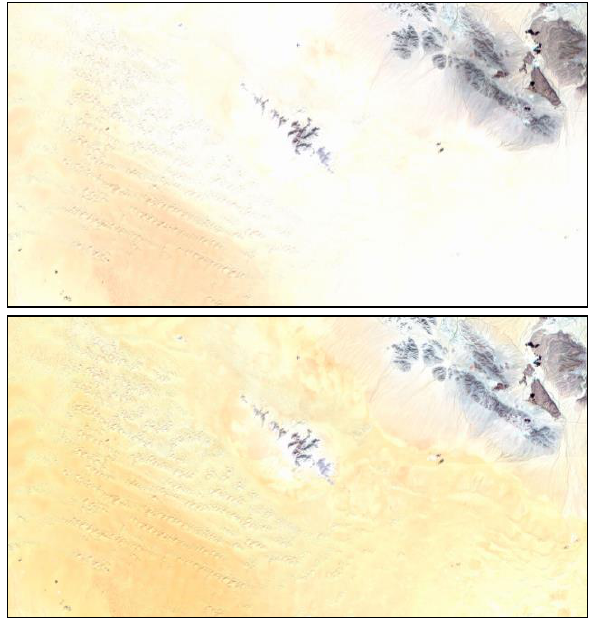
Figure 2. Detail of the Laguna Salada, a dry lake in the Sonoran Desert, before (above) and after (below) desaturation The exposure correction algorithm automatically scans the mosaic for large groups of pixels with high values relative to the remaining pixels in the mosaic. The algorithm then proceeds to decrease the DN values for the group of bright pixels, this ensures that detail is retained when applying a histogram enhancement. Furthermore, a gradient along the edges of the group is applied to ensure a smooth transition from the unaltered pixels to the altered group of